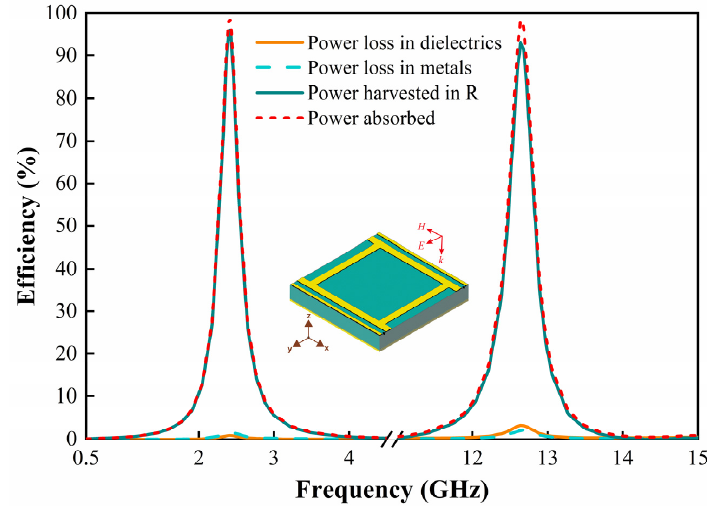
Figure 4. The power absorption, loss, and harvesting efficiency of the metasurface array under incident plane wave irradiation in the − z -direction.